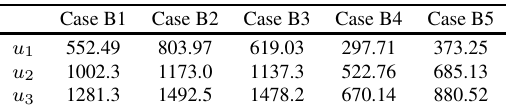
Table 4 The maximum control forces before satuaration ( τ = 25 ms)